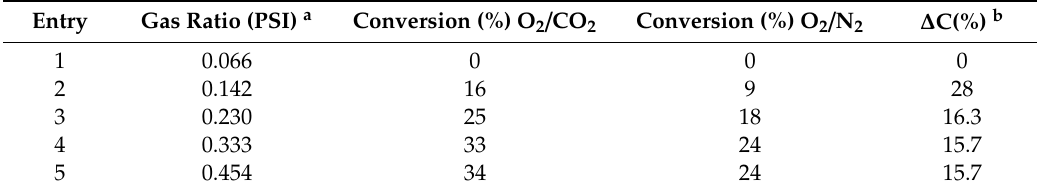
Table 1. E ff ect of the CO 2 on oxidation of cyclohexene over MCN Ref [31] (Reproduced from [31]; copyright (2011), Royal Society of